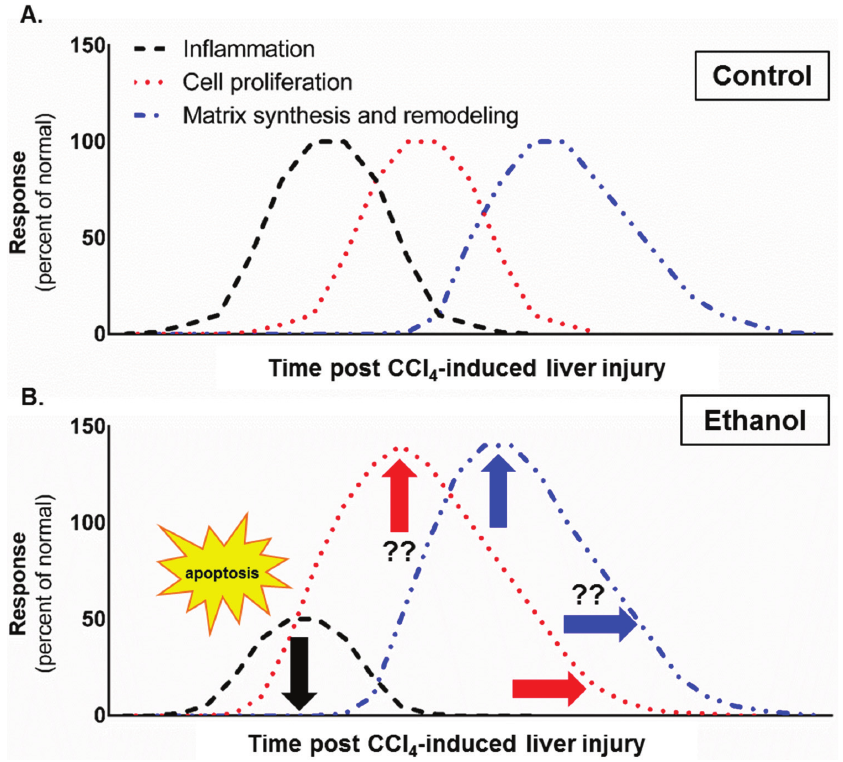
Figure 12. Effect of moderate ethanol feeding to mice on the liver wound healing response after acute hepatotoxin exposure. In ( A ), three phases of wound healing, inflammation (black dotted line), cell proliferation (red dotted line) and HSC activation, matrix synthesis and remodeling (blue dotted line) are depicted as overlapping curves which peak at 100% of normal response after acute CCl 4 ; In ( B ), the effect of moderate ethanol on these three phases of wound healing after acute CCl 4 exposure are depicted. The arrows added to the graph indicate that ethanol decreased (black downward arrow), prolonged (red right arrow) or enhanced (blue upward arrow) the related phase of the wound healing response. In brief, the data contained in this study demonstrated that early after CCl 4 -induced acute liver injury, inflammation is reduced in ethanol-fed mice relative to pair-fed mice. Reduced inflammation was associated with increased hepatocyte apoptosis (yellow “apoptosis” star), which occurred in parallel with a prolonged hepatocyte proliferative response. Moreover, indices of HSC activation were enhanced (peak values greater) in ethanol-fed mice. Finally, matrix degradation was prolonged in livers from ethanol-fed mice. Question marks indicate that more data is required to determine whether or not the ethanol-mediated effect, enhancement or prolongation, occurs in that phase of the wound healing response. We propose that reduction in TNF α , a surrogate marker for hepatoprotective inflammation, in ethanol-fed mice was responsible for increased apoptotic hepatocyte death and, therefore, the need for more robust hepatocyte proliferation, ECM synthesis and remodeling after CCl 4 -induced acute liver